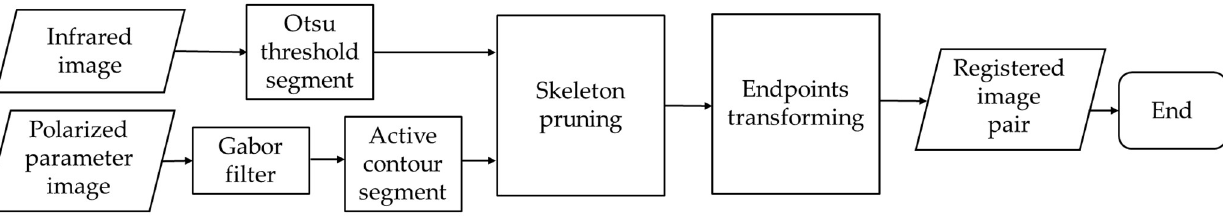
Figure 1. Flow chart of the proposed SSR.